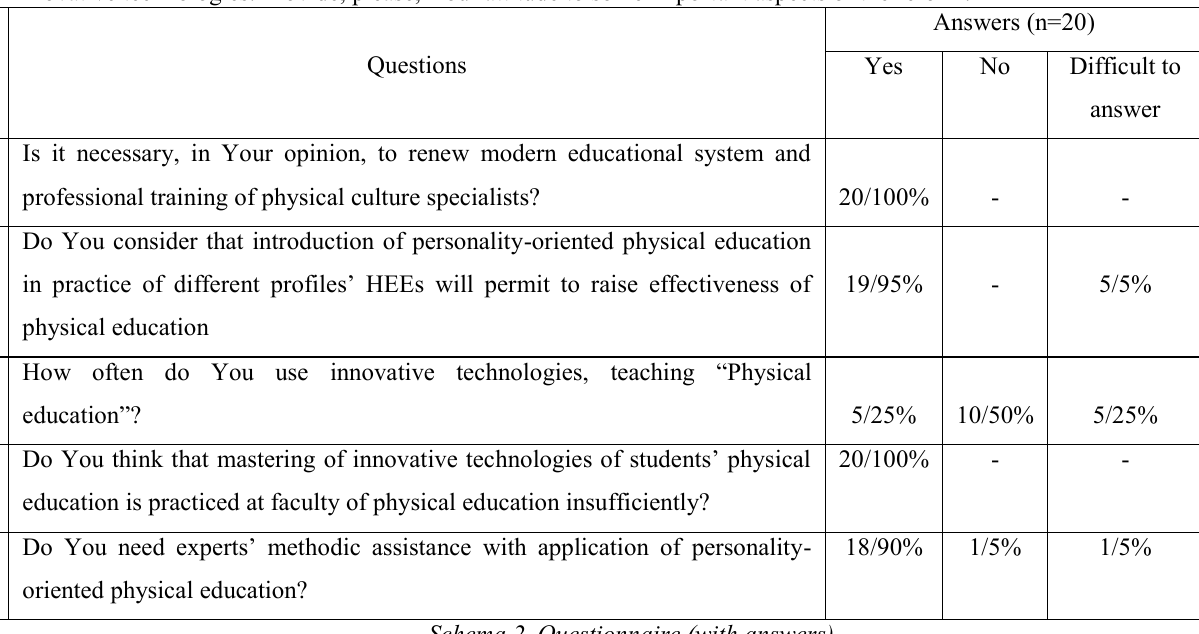
Schema 2. Questionnaire (with